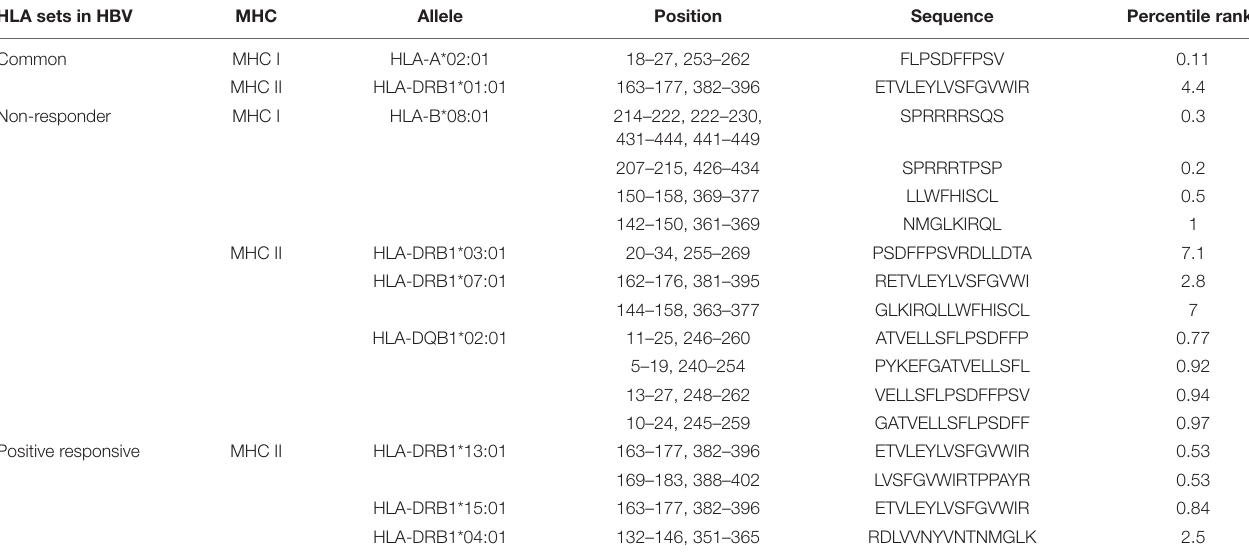
TABLE 2 | Predicted MHC class I and II epitopes of the designed virus-like particle (VLP)-based vaccine. HLA sets in HBV MHC Allele Position Sequence Percentile rank*